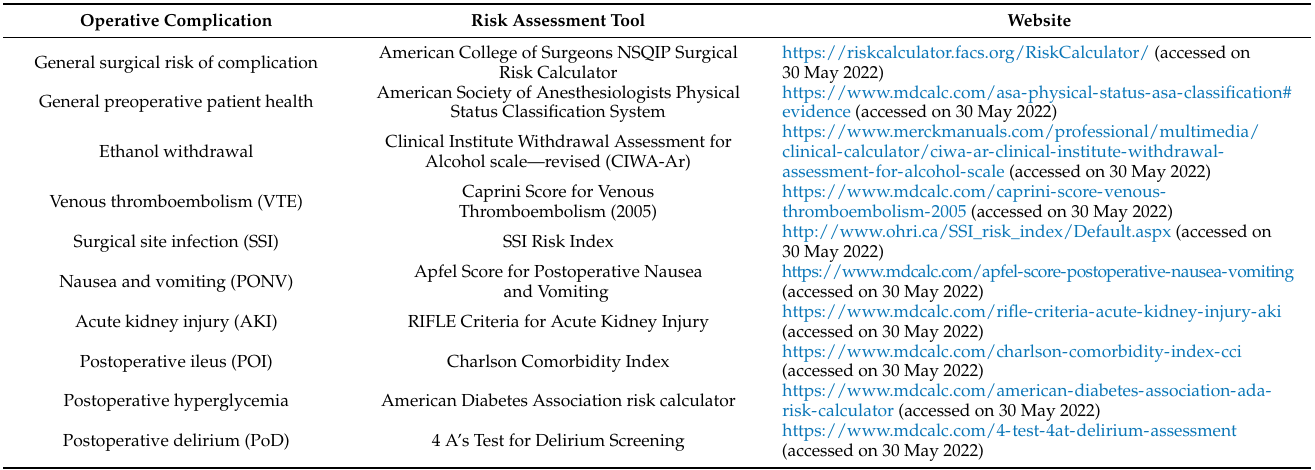
Table 3. Examples of Risk Assessment Tools Available for CPOE Systems as Clinical Decision Support